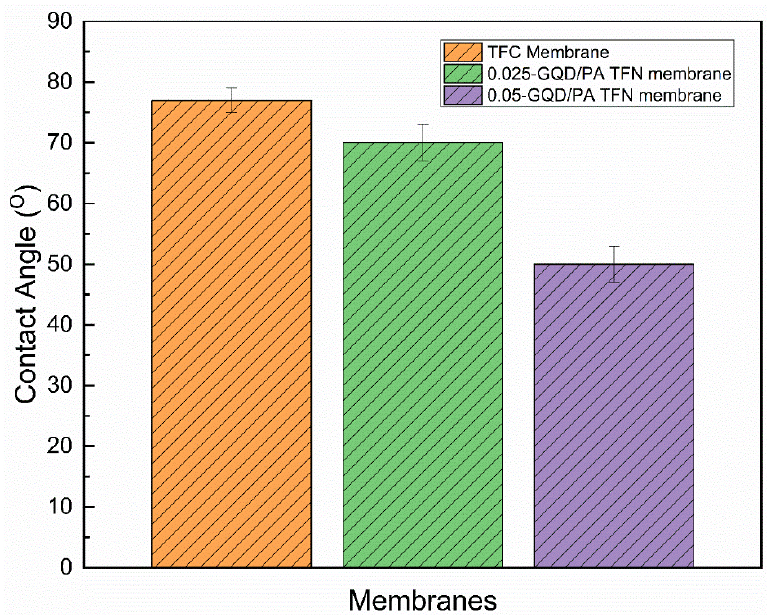
Figure 8. Contact angle analysis of the TFC nanofiber membrane sample and the TFN nanofiber membrane sample with 0.025-GQD/PA TFN and 0.05-GQD/PA TFN.